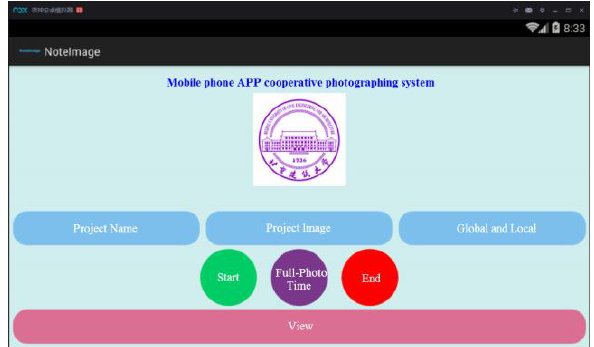
Figure 2. The system